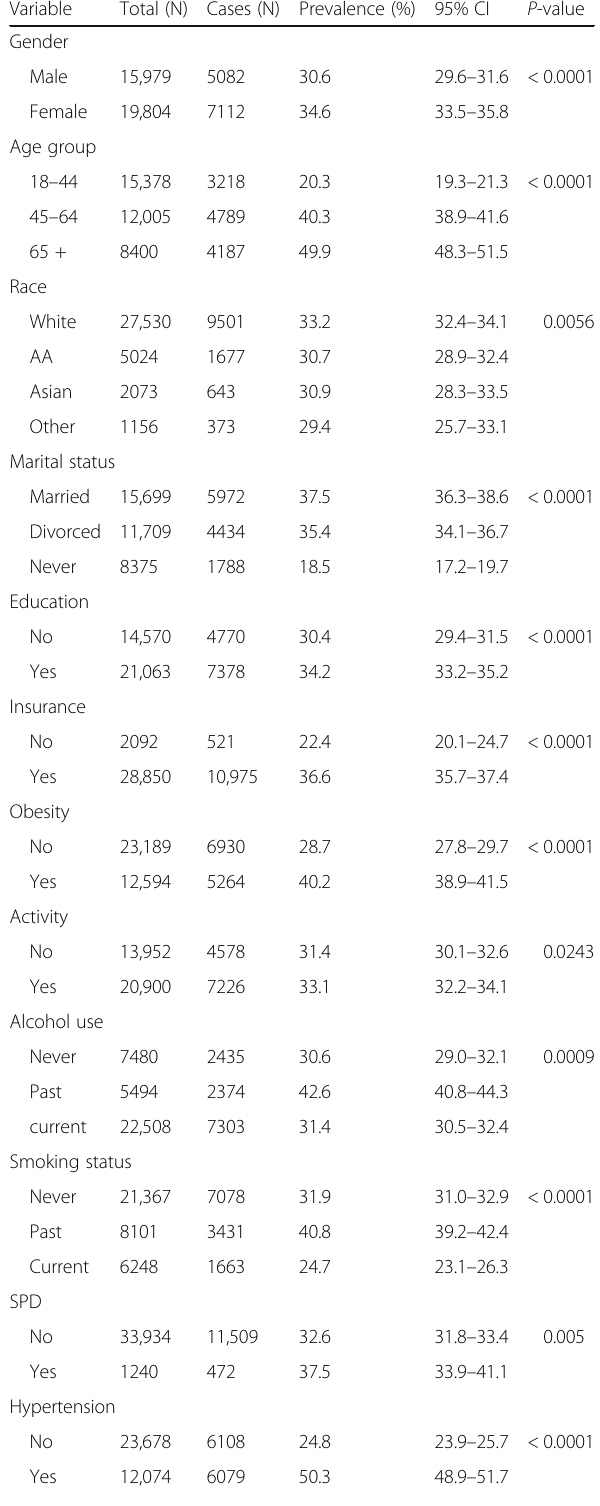
Table 1 Type 2 diabetes screening prevalence (%) Variable